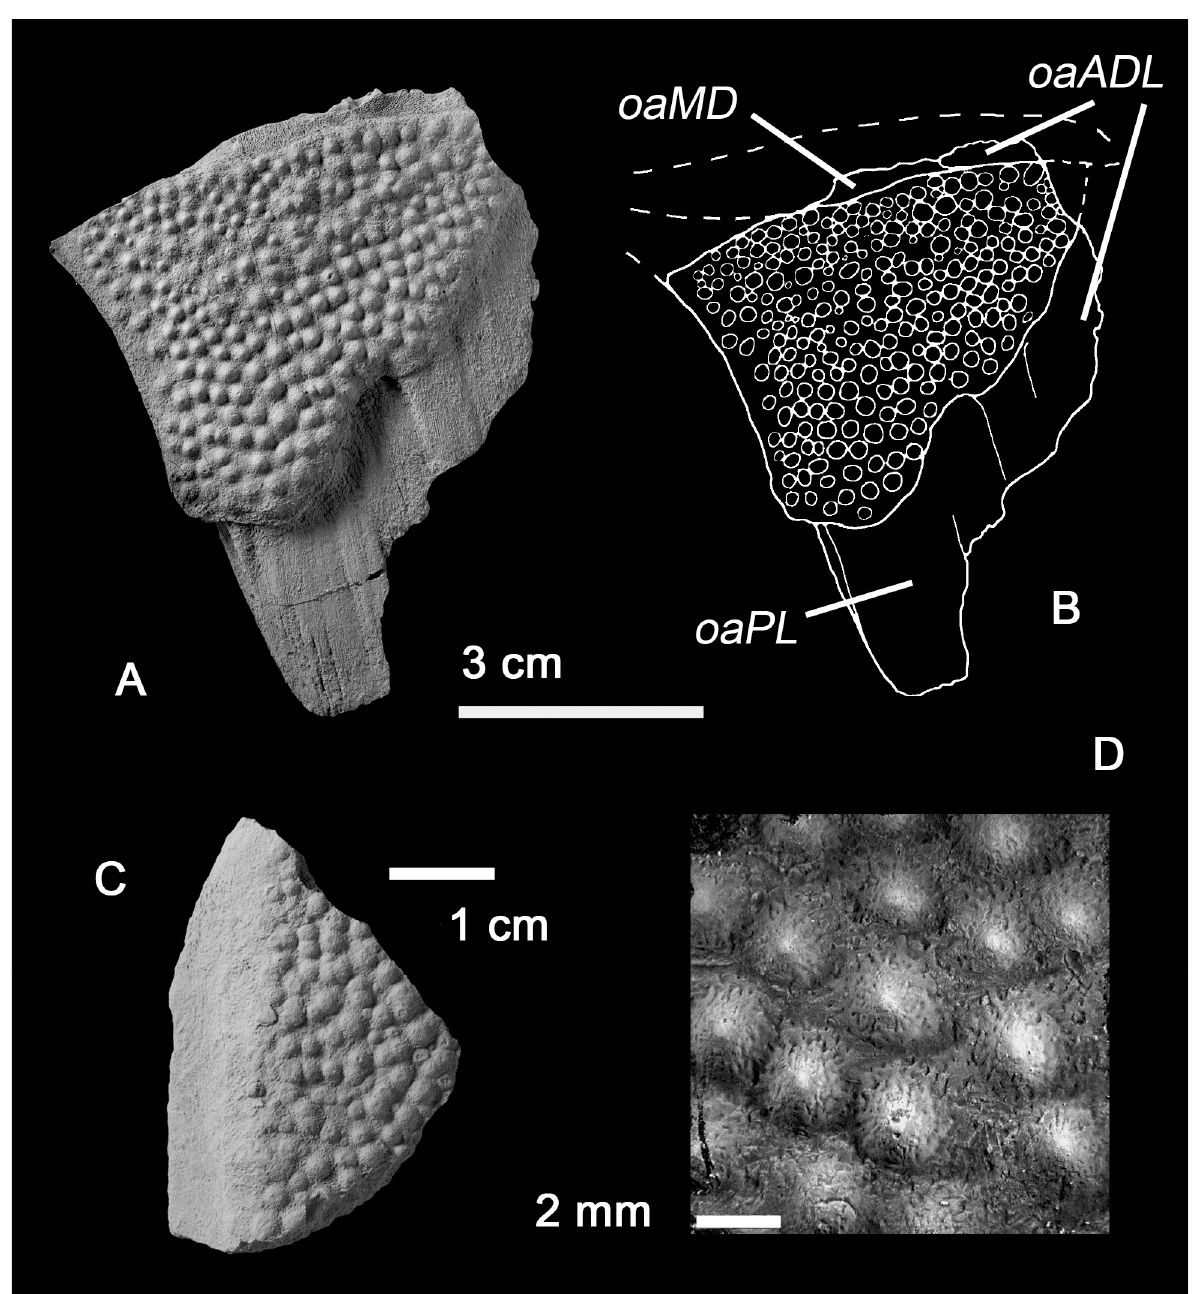
Fig. 3. Arthrodira gen. et sp. indet. Lipetsk Region, Central Russia, right bank of the Rykhotka River (right tributary of the Don River), a local quarry approximately 100 m north of the Voskresenskoye village. A, D , right posterior dorsolateral plate PIN 2921/3267; B , schematic drawing of the same view in A; C , bone fragment PIN 2921/3268; D , a fragment of dermal sculpture in PIN 2921/3267. Abbreviations: oaADL , overlap area for the anterior dorsolateral; oaMD , overlap area for the mediodorsal; oaPL , the main overlap area for the posterior lateral